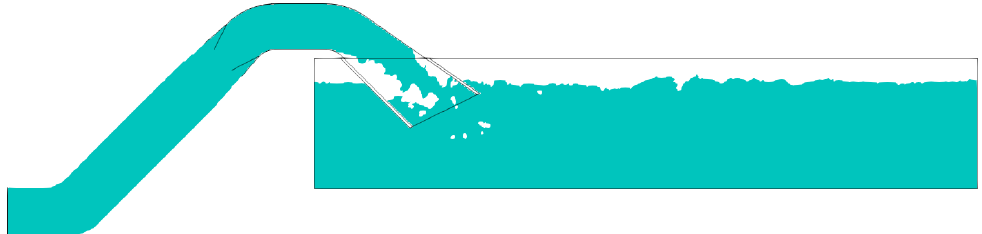
Figure 4. Bubbles inside the siphon when calculating from initial condition (28)–(30). Front part of a cut at z =